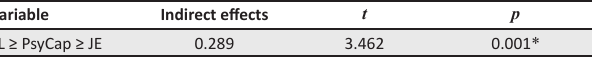
TABLE 7: Specific indirect effects.